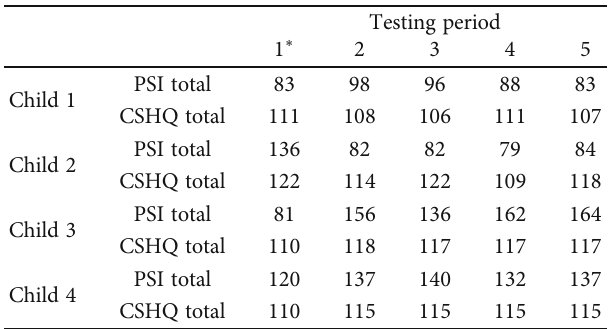
Table 2: Parent Stress Index and Children ’ s Sleep Habit Questionnaire total scores for each child.